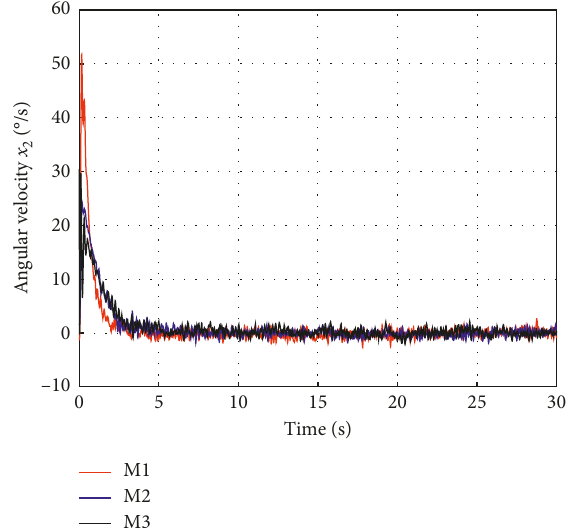
under the initial 2